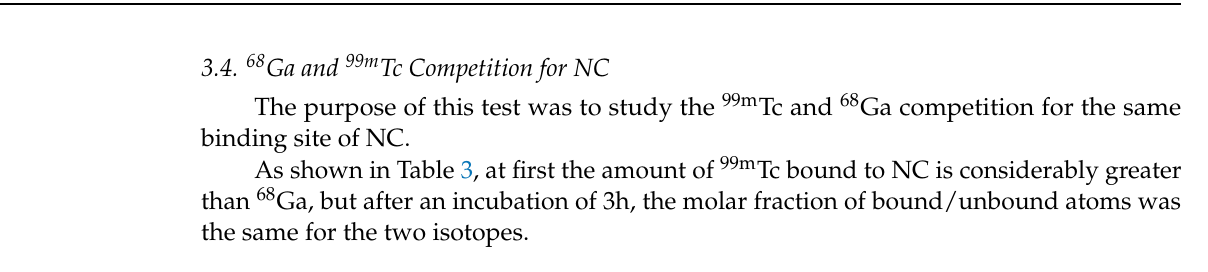
Table 3. 99m Tc and 68 Ga amount bound/unbound to NC reported as molar fraction. Mean